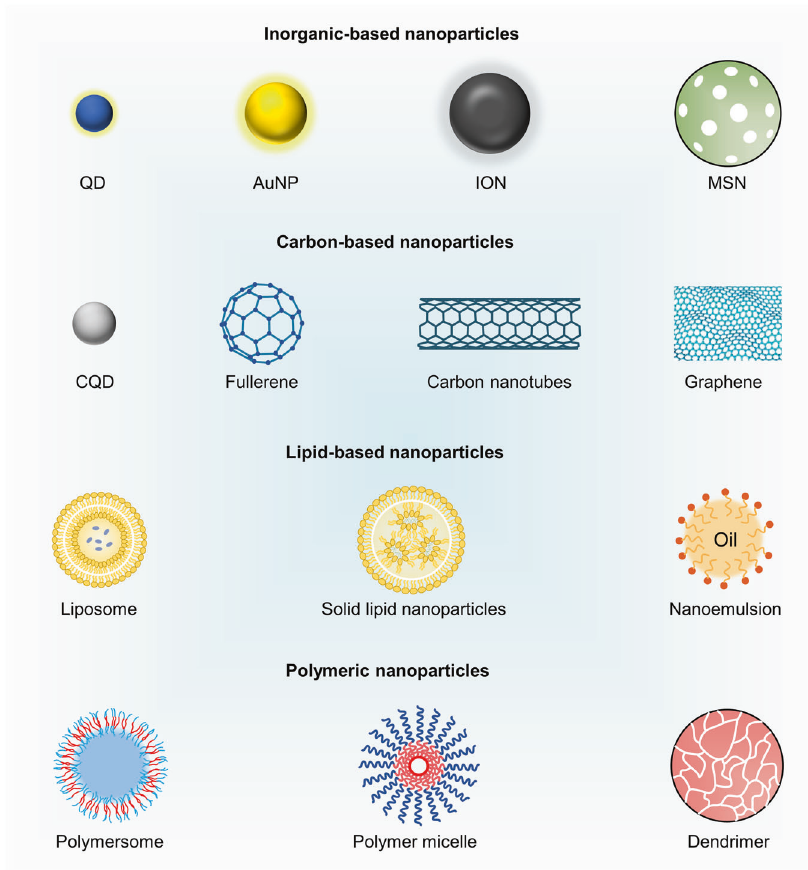
Fig. 2 Schematic illustration of various inorganic-based nanoparticles, carbon-based nanoparticles, lipid-based nanoparticles, and polymeric nanoparticles. QD quantum dot, AuNP gold nanoparticle, ION iron oxide nanoparticle, MSN mesoporous silica nanoparticle, CQD carbon quantum